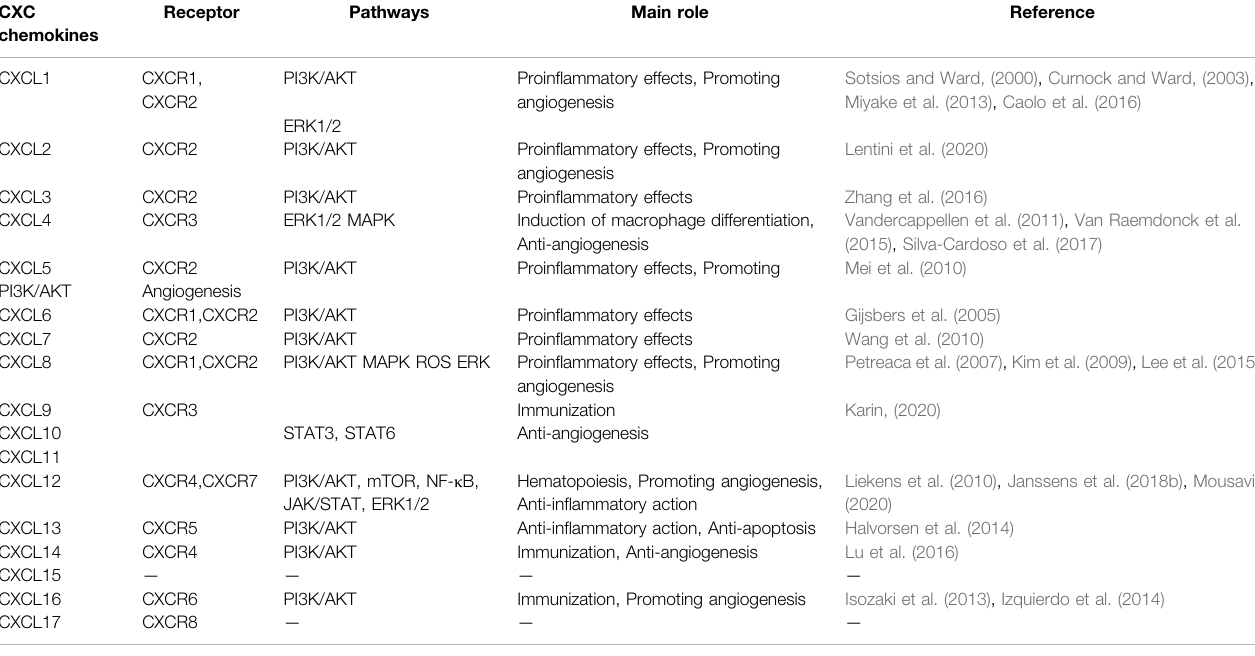
TABLE 2 | Receptors, signaling pathways of CXC chemokines, and their role in cardiovascular disease. CXC chemokines